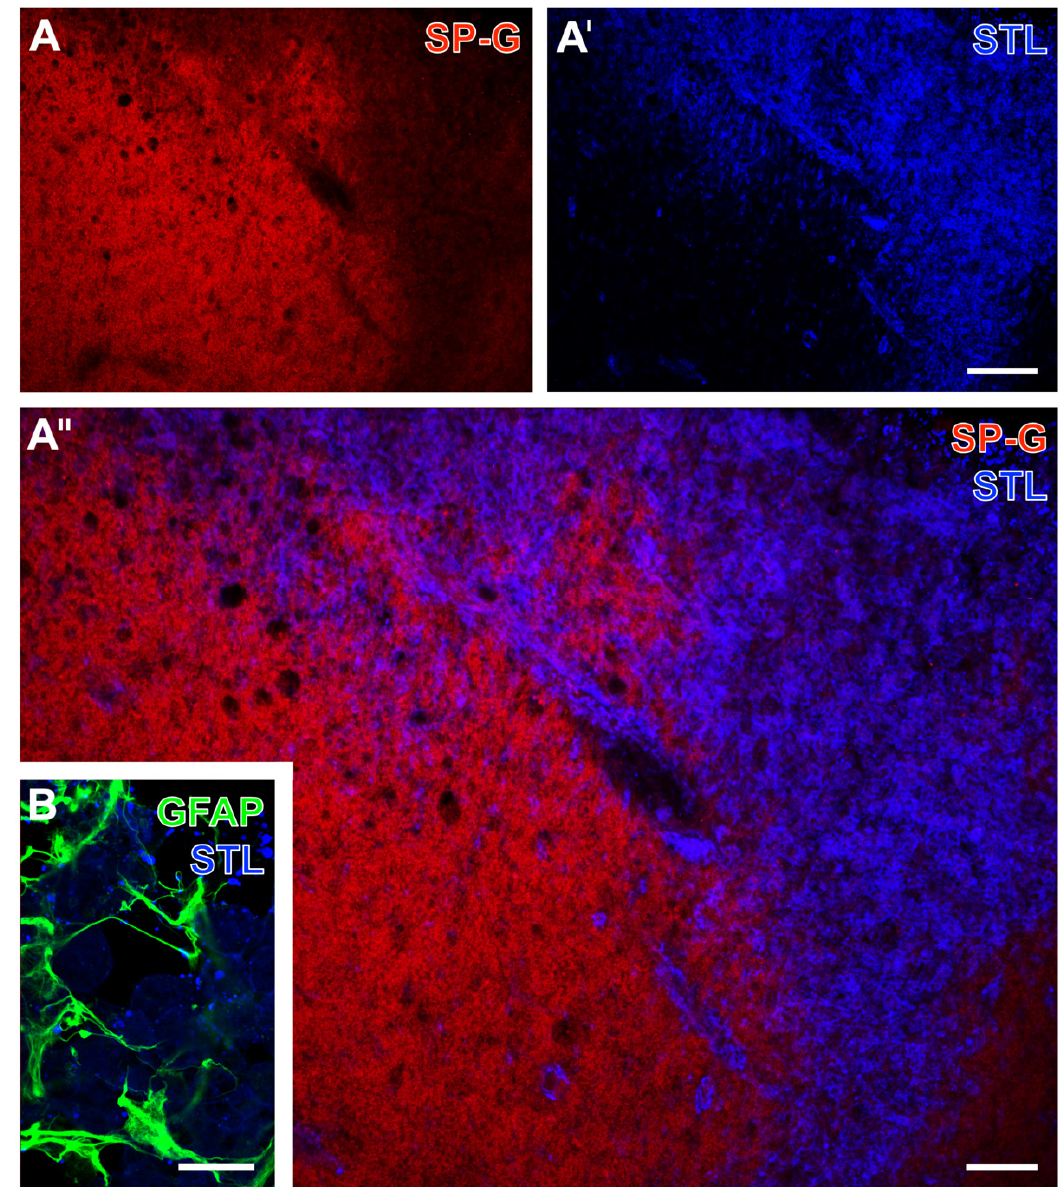
Figure 11. Spatial relationships between surfactant protein-G (SP-G), vascular and astroglial elements after focal cerebral ischemia in sheep. Representative double fluorescence labeling of SP-G and lectin-based visualization (STL) of the vasculature and inflammatory cells at the ischemic border zone after two weeks of focal cerebral ischemia ( A – A” ). Additionally, astroglial GFAP in terms of a glial scar and STL-binding sites of the vasculature and inflammatory cells at the ischemic border zone, captured by laser-scanning microscopy ( B ). Scale bars: A’ (also valid for A ) = 200 µ m, A” = 100 µ m, B = 25 µ